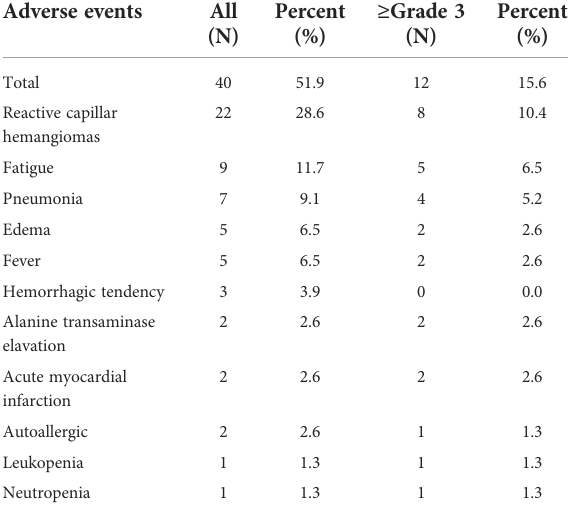
TABLE 7 The adverse events of